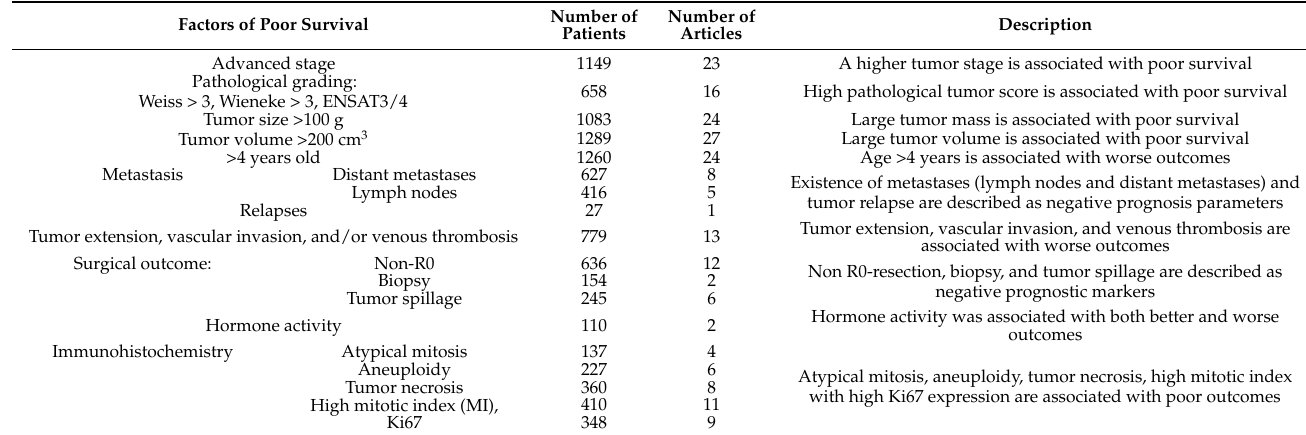
Table 5. Factors of poor